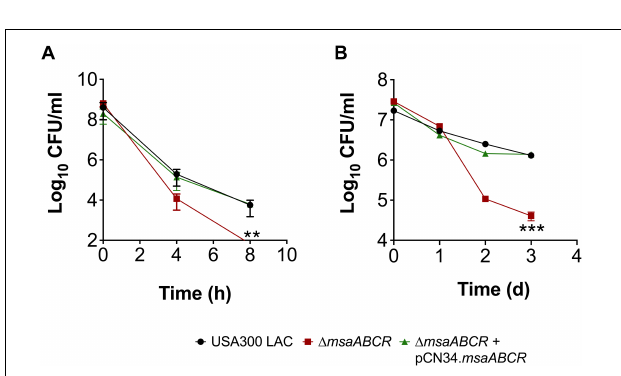
FIGURE 3 | Measurement of persister cells in the presence of aminoglycoside stress. (A,B) The killing of USA300 LAC, (cid:77) msaABCR , and (cid:77) msaABCR + pCN34. msaABCR cells in the presence of tobramycin at the indicated time points. Strains grown to stationary phase and on biofilms were exposed to tobramycin (20 × MIC). (A) Tobramycin treatment in stationary-phase culture. (B) Tobramycin treatment on catheter biofilms. Error bars indicate SEM of at least three independent experiments. Statistical significance was determined using ANOVA followed by Tukey’s multiple comparison tests. **, P < 0.001; ***, P < 0.0005.